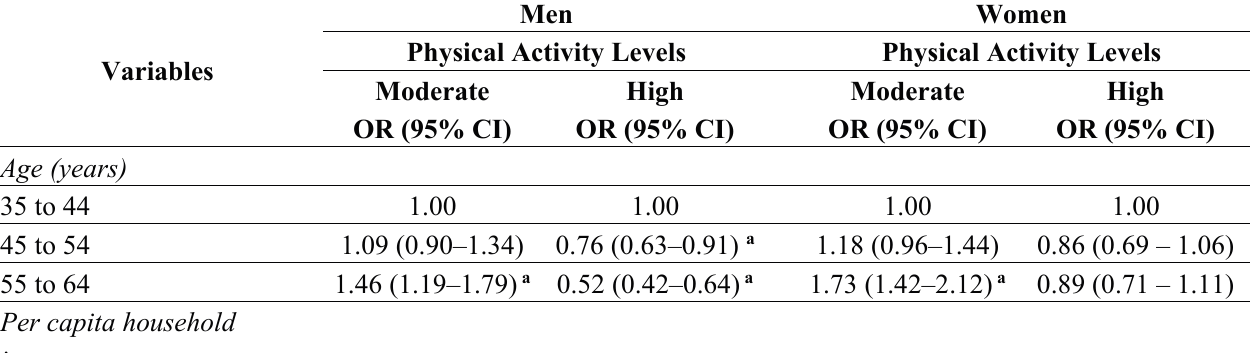
Table 2. Crude Odds Ratios for physical activity, according to sociodemographic, body and behavioral characteristics, in adults (35–64 years-old), categorized by sex. ELSA-Brasil